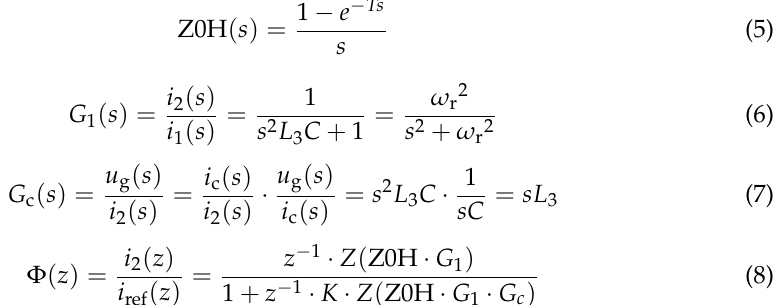
Figure 4. Block diagram of the digital current controller.